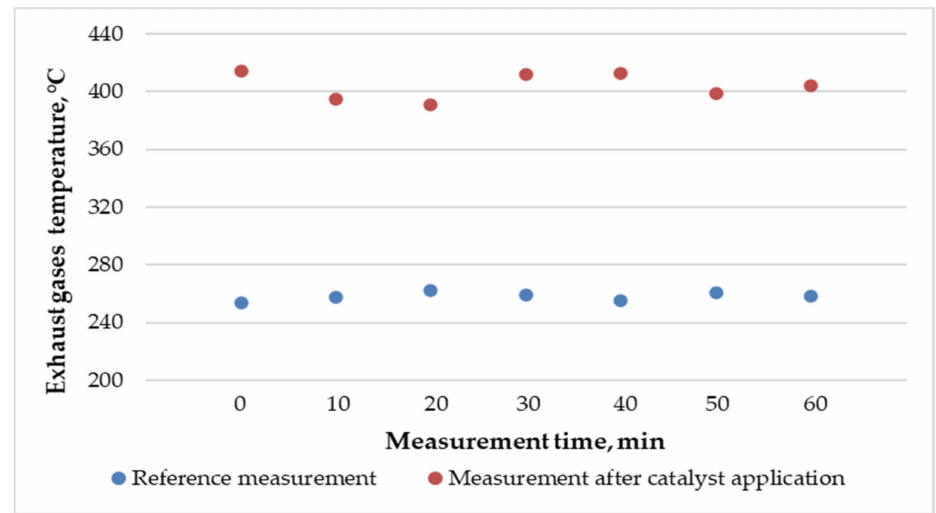
Figure 6. Comparison of exhaust gases temperature without and with the use of a catalyst.